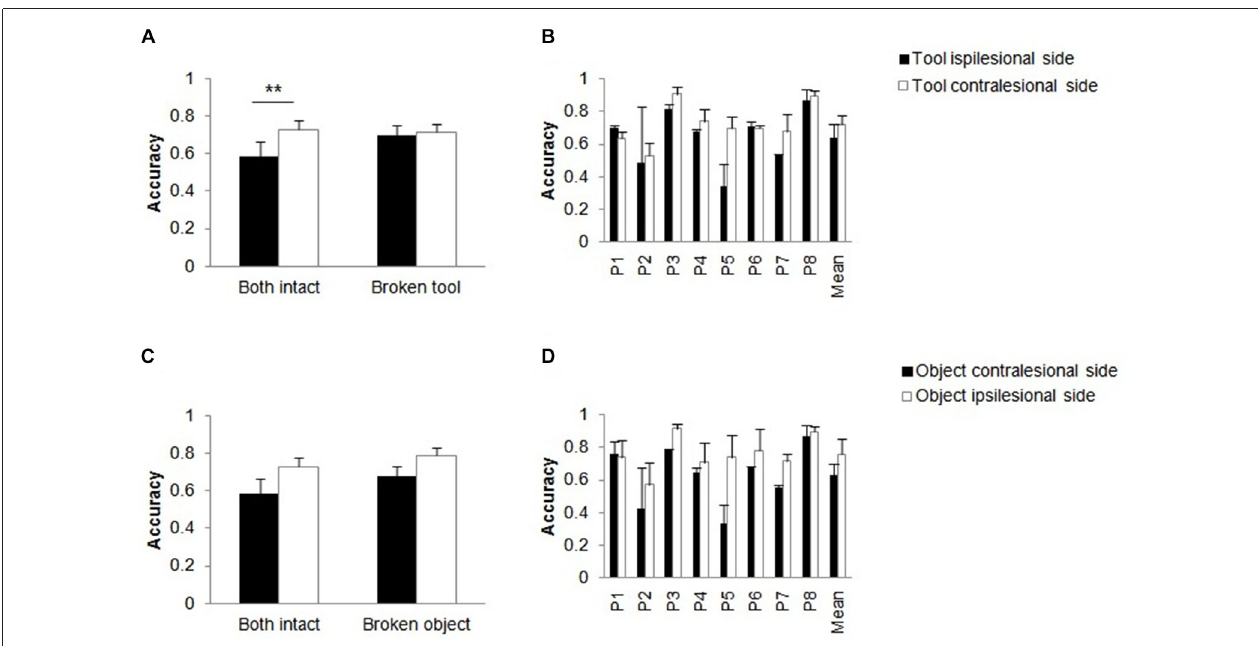
FIGURE 4 | Action-related objects only. Effects of breaking the handle of the tool (A,B) or the object (C,D) . Mean accuracies for action-related objects as a function of whether the tool handle (A) or the object handle (C) was broken compared to when both handles were intact. Mean patient accuracies (B,D) with error bars denote SE. Asterisks denote significance ( ∗∗ p <